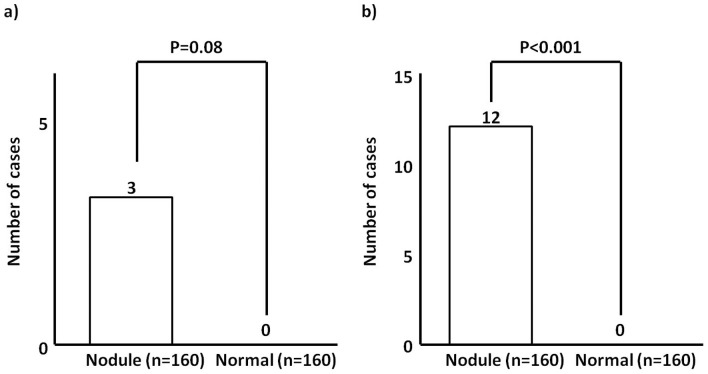
Number of cases confirmed as a) malignant and b) suspicious and malignant by fine needle aspiration biopsy.